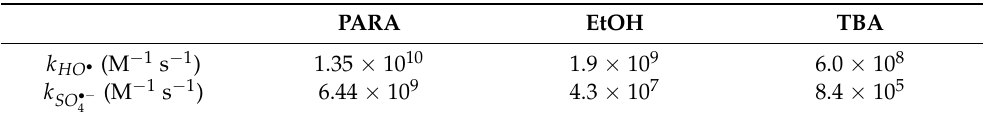
Table 1. The second order rate constants of HO • and SO 4 •− with both quenchers (EtOH and TBA) and PARA